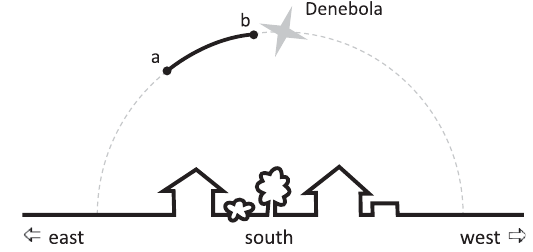
TABLE II. Test results of secondary school students ( n ¼ 42 ).